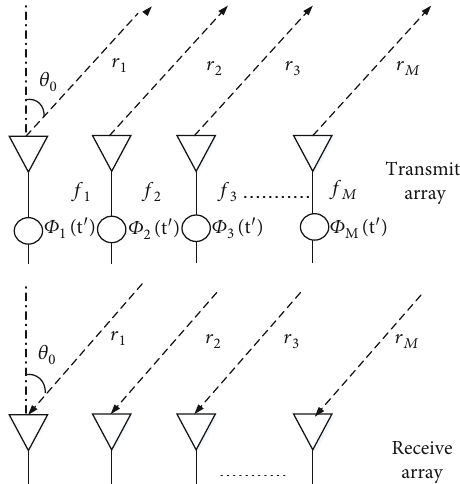
Figure 3: Our proposed con fi guration of